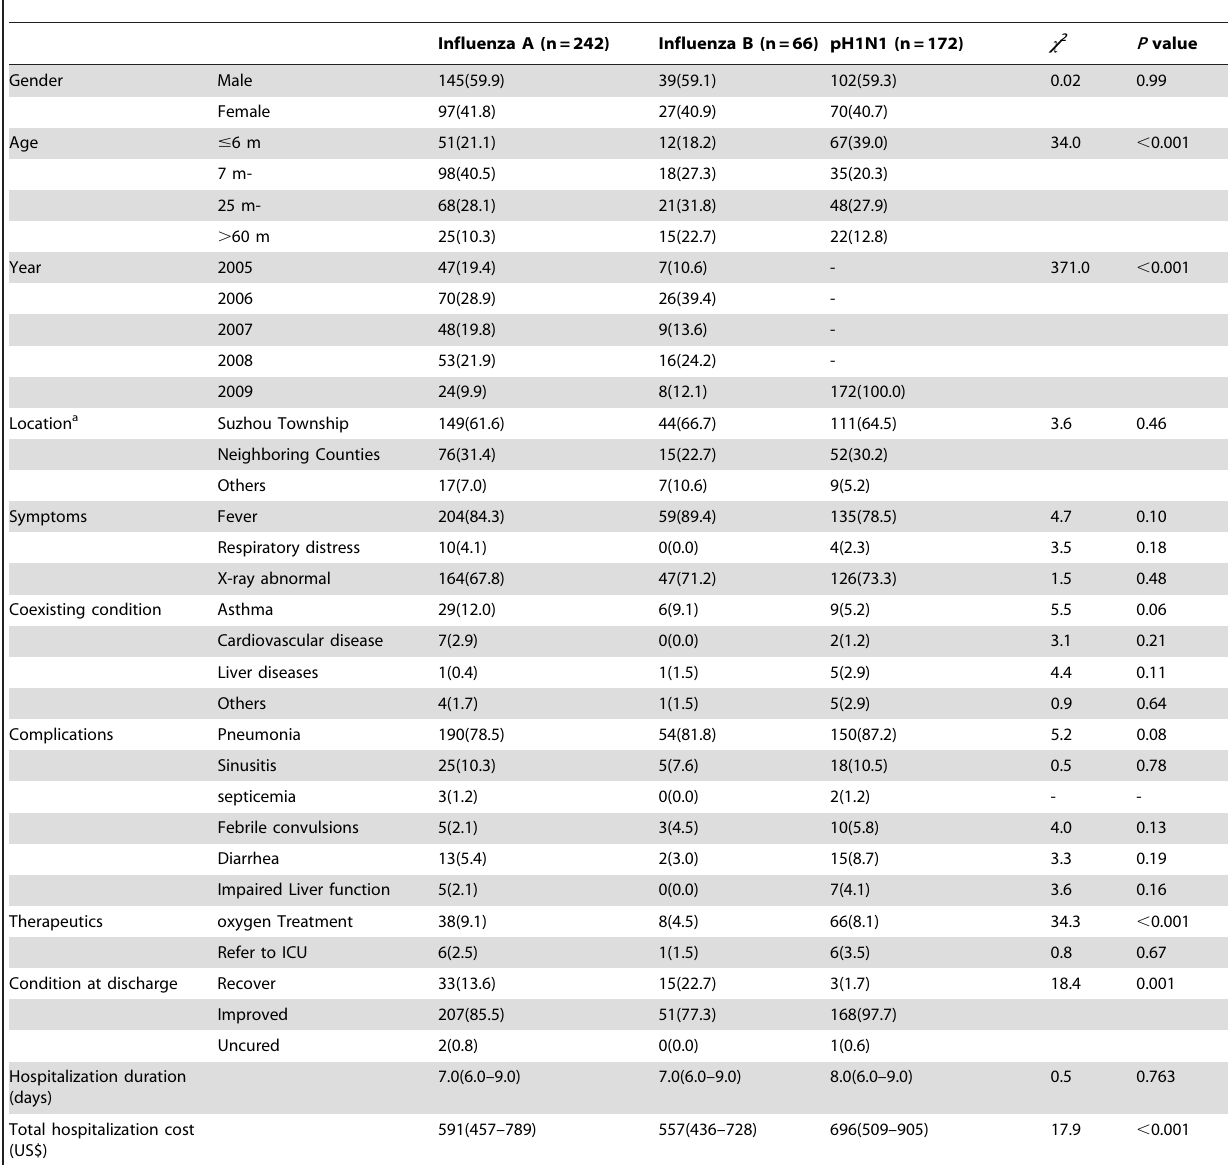
Table 1. Population profile and primary clinical characteristics of influenza positive children hospitalized in Suzhou Children Hospital from 2005 to 2009